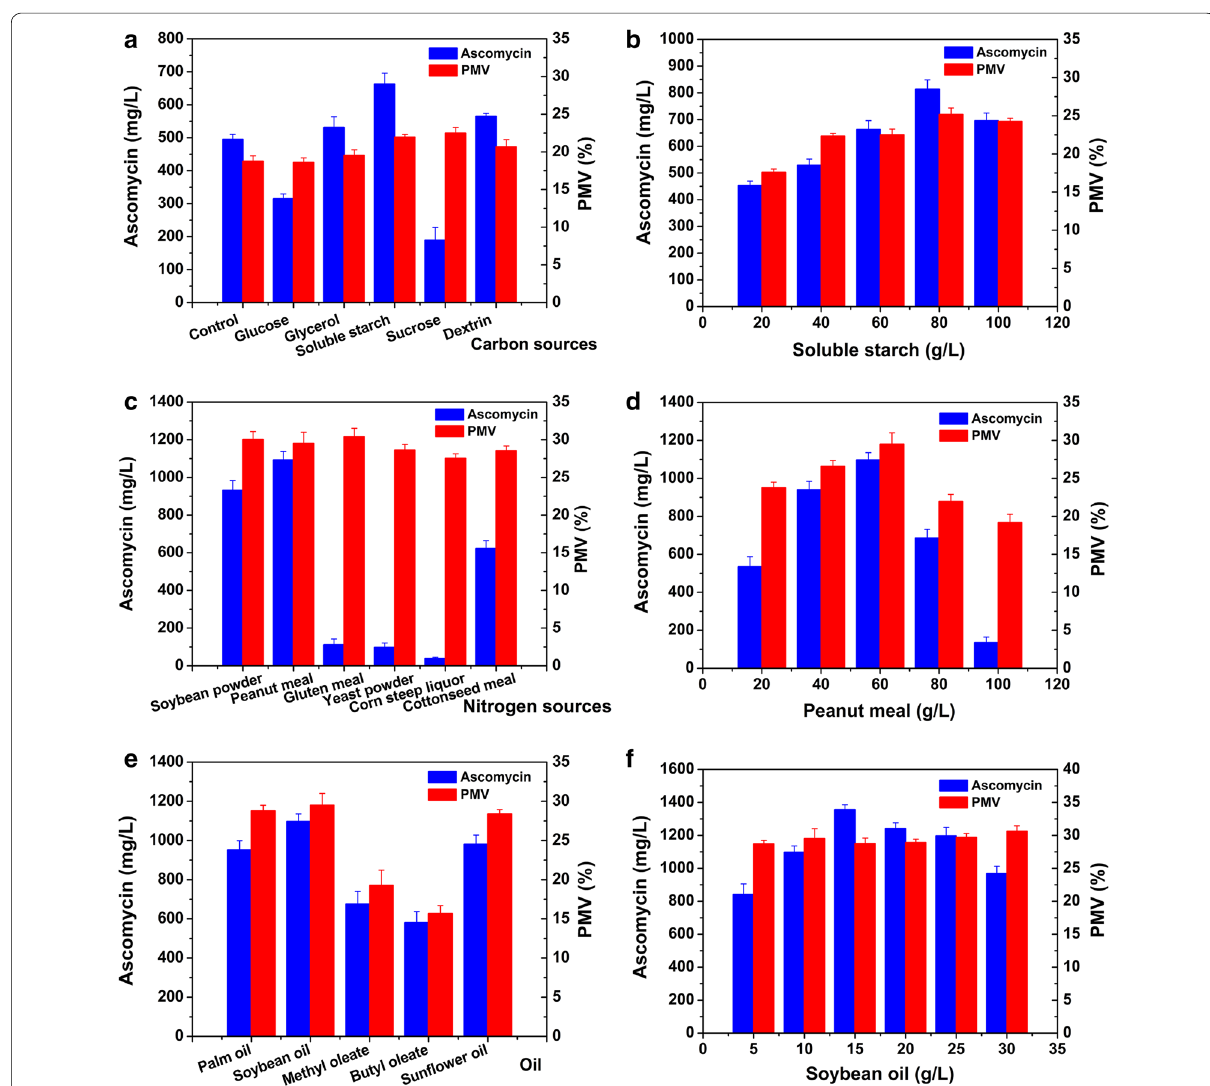
Fig. 3 Effect of different fermentation media on ascomycin production by S. hygroscopicus SKF-36. Effect of different carbon sources ( a ), soluble starch concentrations ( b ), nitrogen sources ( c ), peanut meal concentrations ( d ), oil ( e ), and soybean oil concentrations ( f ) on ascomycin production and biomass of